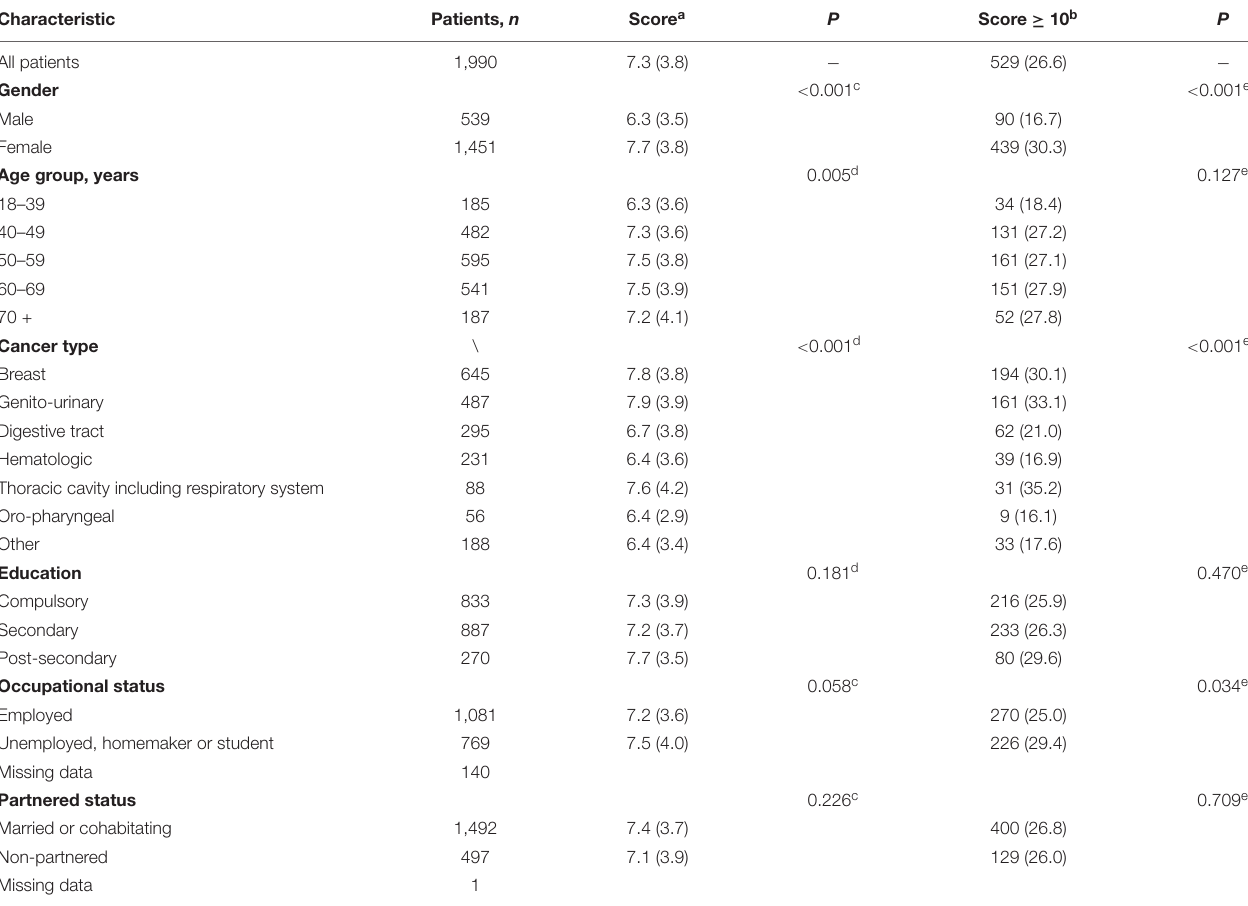
TABLE 2 | Anxiety intensity scores and prevalence according to HADS-A, by sociodemographic and clinical characteristic. Characteristic Patients,